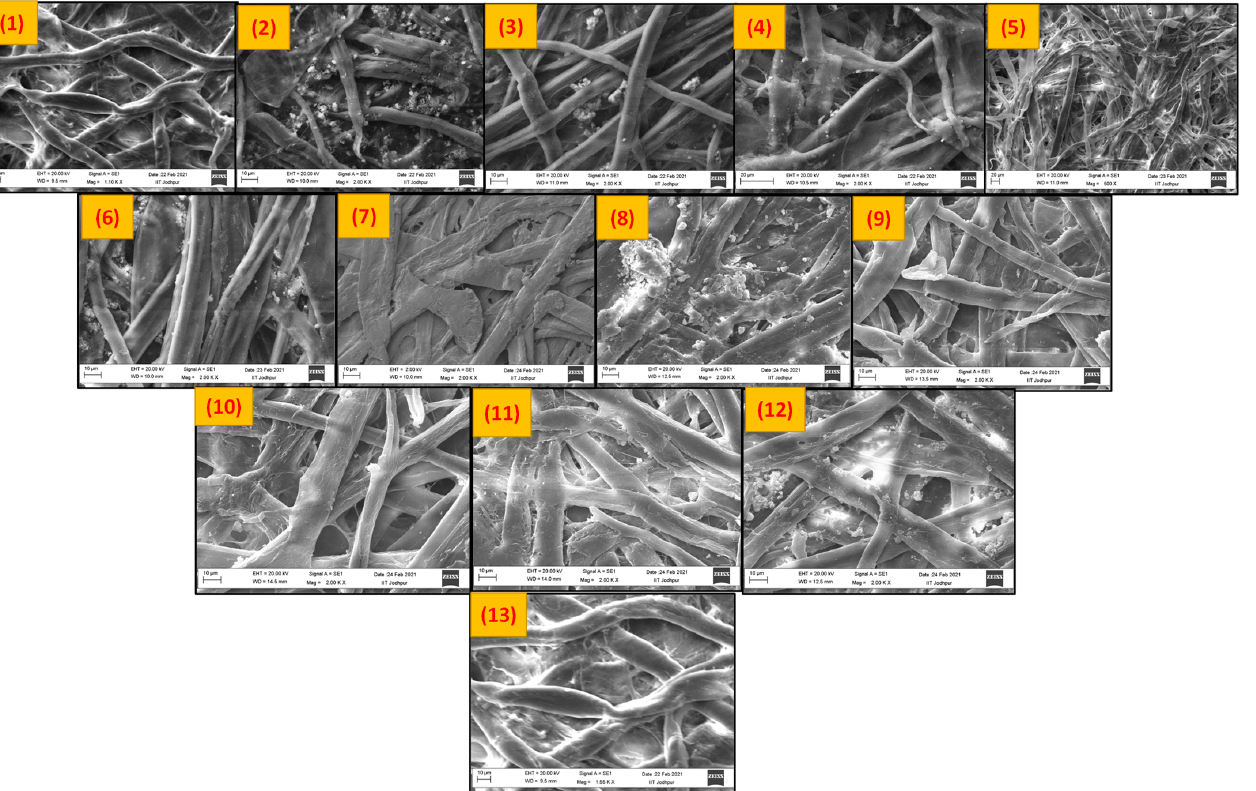
Figure 2. SEM images of different types of papers available: (1) Whatman no. 1, (2) bond paper, (3) 200 GSM card sheet, (4) blotting paper, (5) paper towel (2 ply), (6) glossy paper, (7) 300 GSM card sheet, (8) practical sheet paper, (9) ivory sheet, (10) sketch sheet, (11) drawing sheet, (12) A 4 paper (67 GSM), and (13) Whatman no. 4.